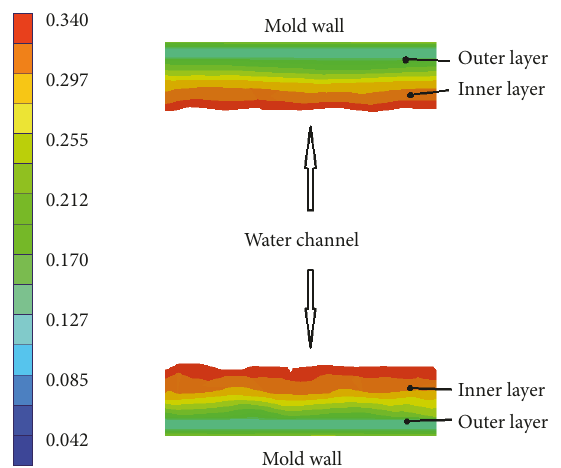
Figure 6: Contour of the circumferential component of orientation